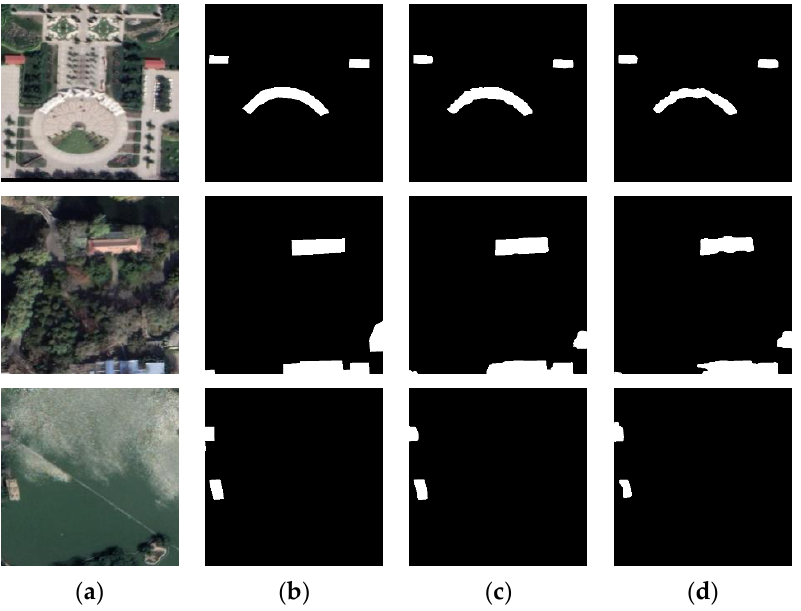
Figure 13. Building extraction results with different loss functions. ( a ) Original image. ( b ) Ground truth. ( c ) Loss CE_BW +Loss Dice . ( d ) Loss CE +Loss Dice . Table 5. Comparison of the accuracy of prediction results of different loss functions. Loss Function Precision